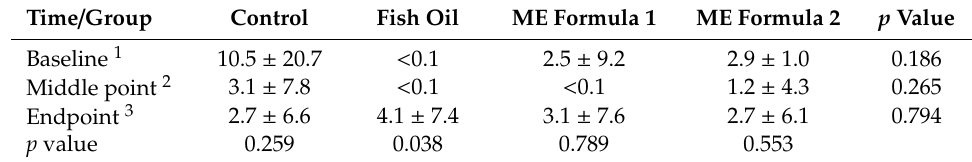
Table 6. DHA content of toddler faeces (ng / g wet weight) in all groups over the 4 weeks. Time / Group